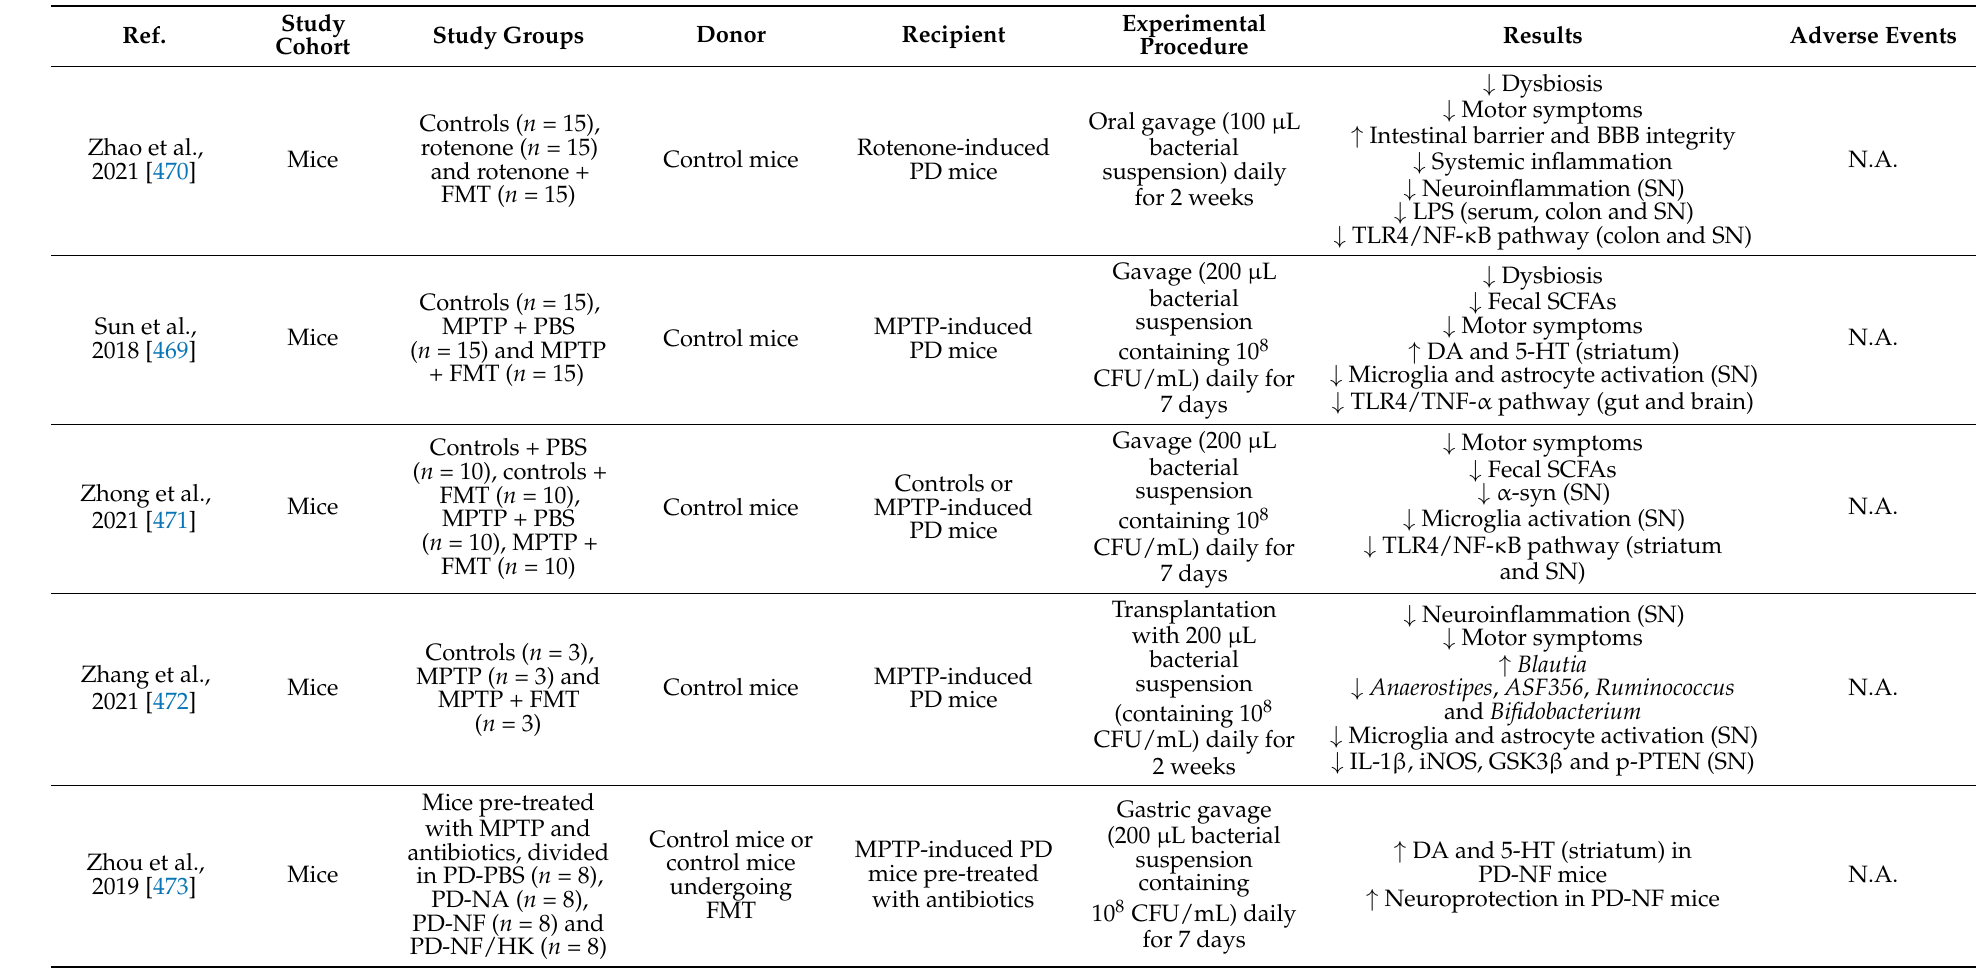
Table 4. Preclinical and clinical studies on the use of fecal microbiota transplantation for Parkinson’s disease.